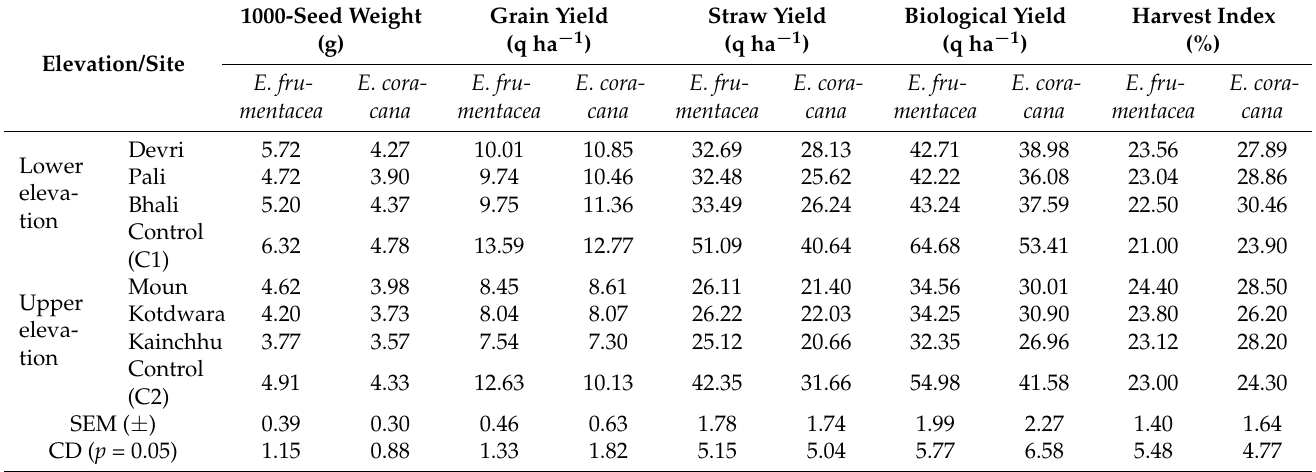
Table 4. Yield attributes of E. frumentacea and E. coracana under G. oppositifolia -based agrofores- try